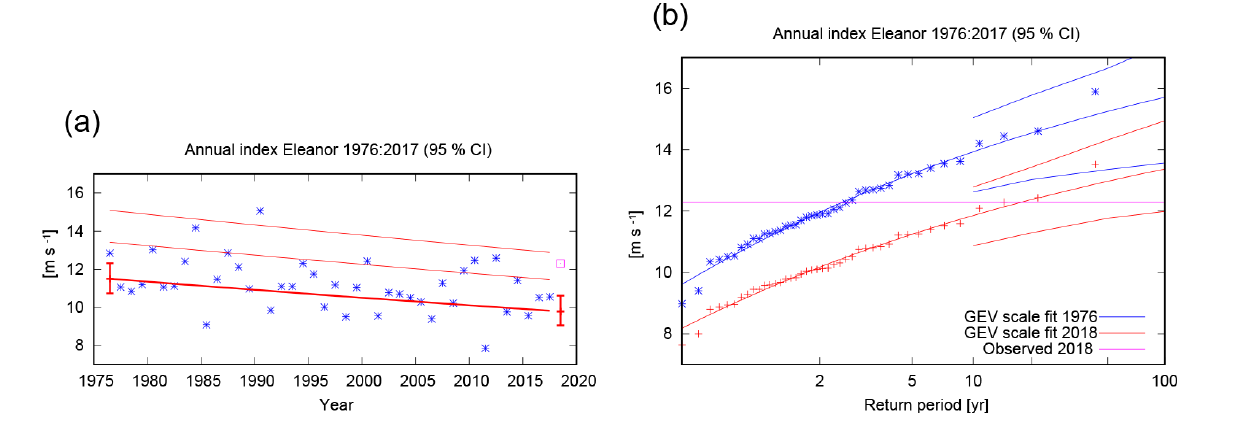
Figure 7. Same as Fig. 4 but for the Eleanor index.